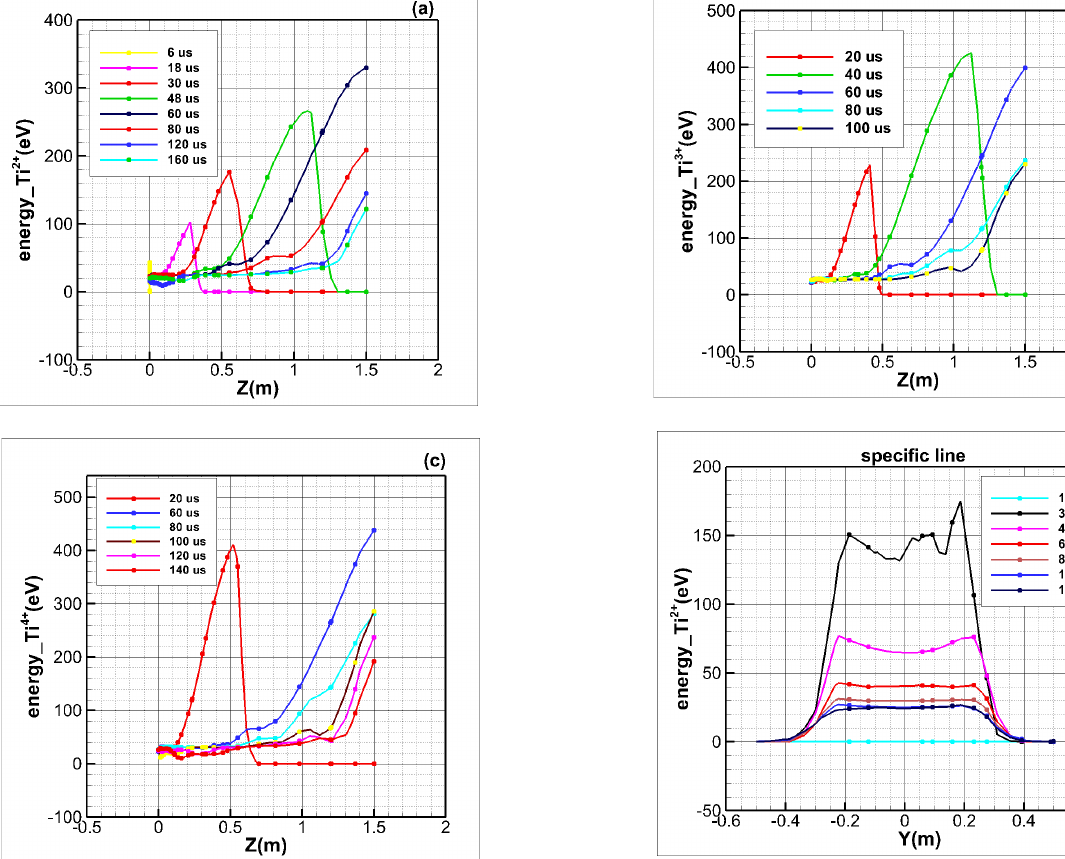
Figure 14. Ion energy distribution along the central axis of the plasma plume: ( a ) Ti 2+ , ( b ) Ti 3+ , ( c ) Ti 4+ , and ( d ) Ti 2+ (specific line). Table 3. Ions’ average energy for different charge